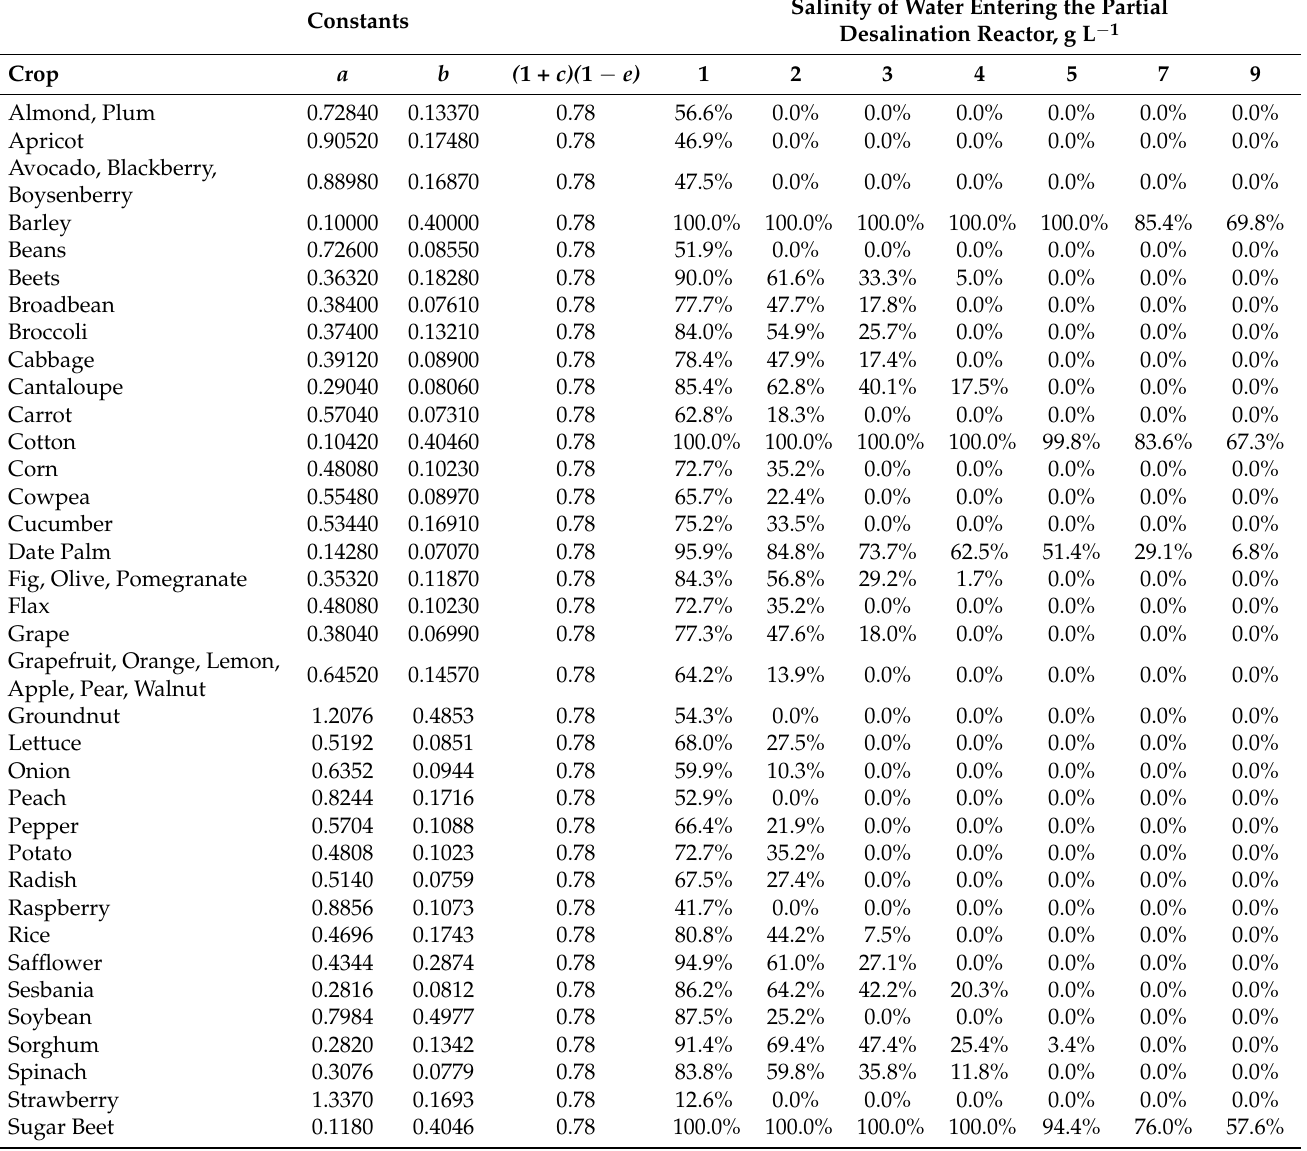
Table A5. Expected crop yield, following partial desalination of irrigation water, when compared to irrigation with